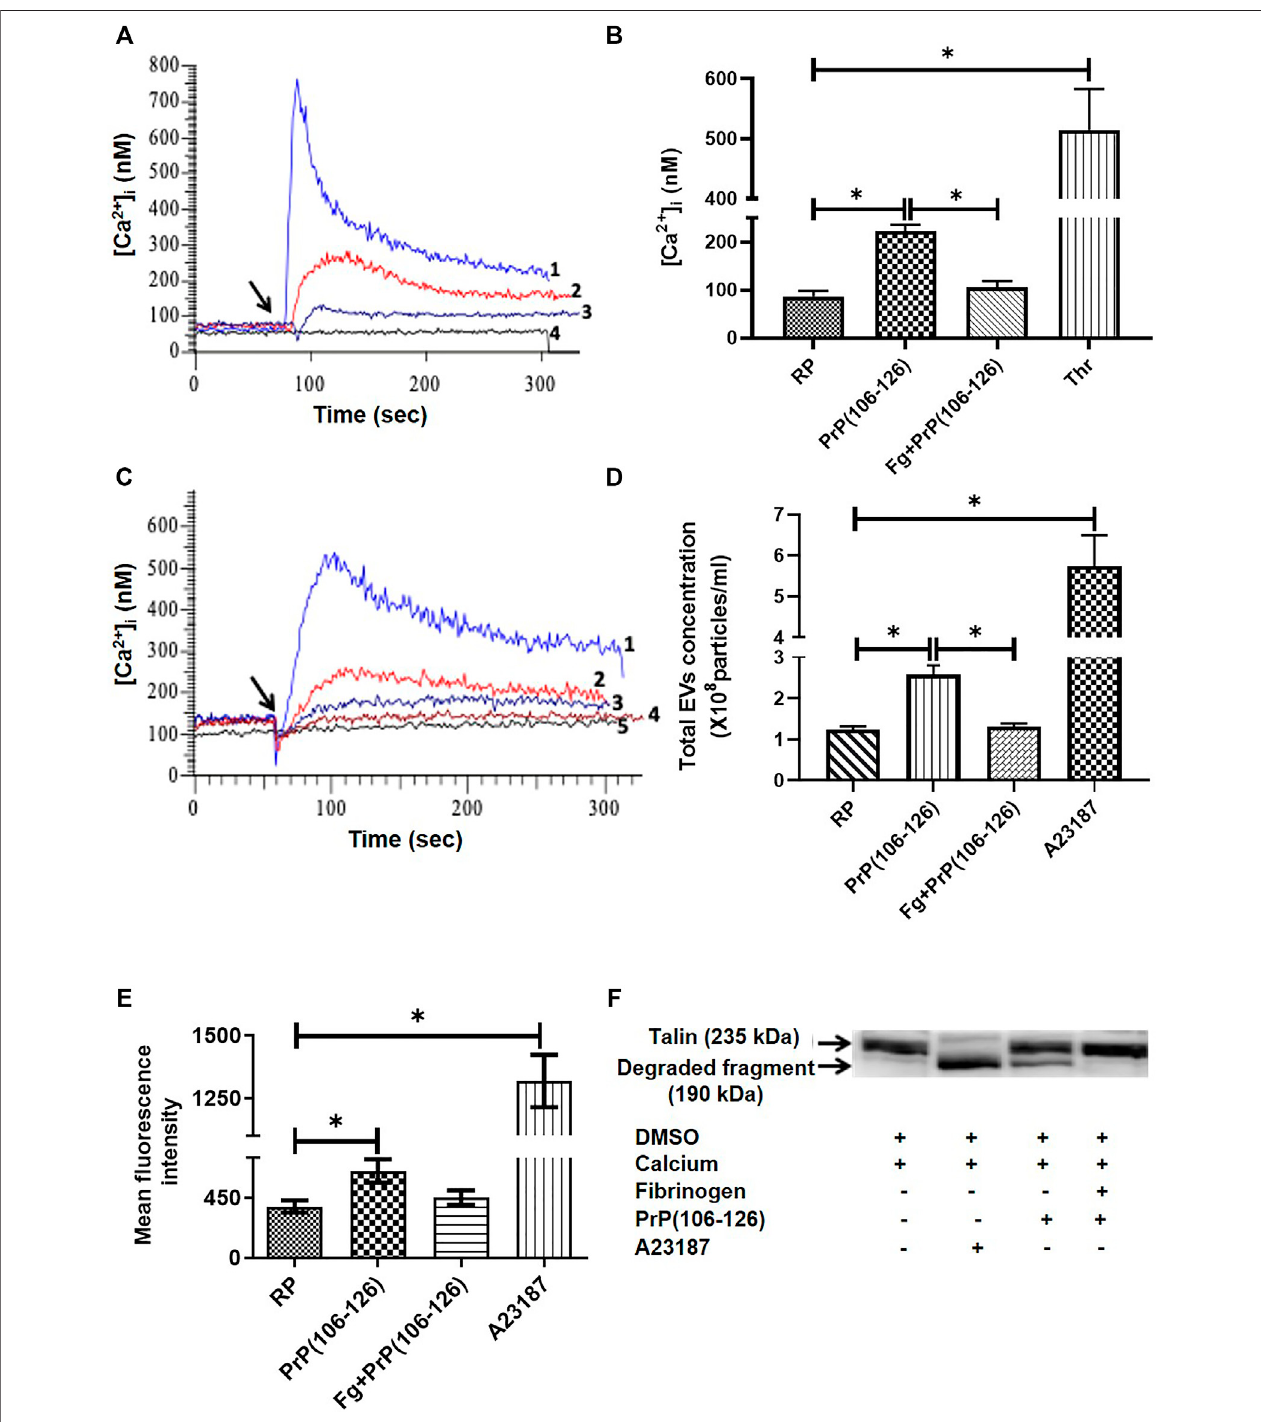
FIGURE 2 | Fibrinogen attenuated PrP(106 – 126)-induced rise in free intracellular Ca 2+ , EV release, calpain activity, and talin degradation in human platelets. (A) Tracings 1 to 4 represent platelets treated with thrombin (0.5 U/ml), PrP(106 – 126) (20 µM), fi brinogen (1 mg/ml) plus PrP(106 – 126), and vehicle, respectively. Ca 2+ (1 mM) was added in all samples. (B) Graphic presentation of corresponding values of panel A in bars. (C) Tracings 1 to 4 represent platelets treated with PrP(106 – 126) (20 µM) alone or in the presence of 0.5 mg/ml, 1 mg/ml, and 2 mg/ml fi brinogen, respectively. Tracing 5, vehicle-treated platelets. Ca 2+ (1 mM) was added in all samples. (D) Extracellular vesicle shedding from PrP(106 – 126) (20 µM)-treated platelets in the presence or absence of fi brinogen (2 mg/ml) characterized with the Nanoparticle Tracking Analyzer.A23187 (1 μ M) wasused asapositivecontrol. (E) Calpainactivation inPrP(106 – 126)(20 µM)-treatedplatelets assayed inthepresence or absence of fi brinogen (2 mg/ml). A23187 was used as a positive control. (F) Immunoblot representing degradation of talin (235 kDa) to its proteolytic fragment (190 kDa). Platelets were treated with different reagents as indicated. Figures are representative of ≥ 3 independent experiments (mean ± SEM, p < .05).